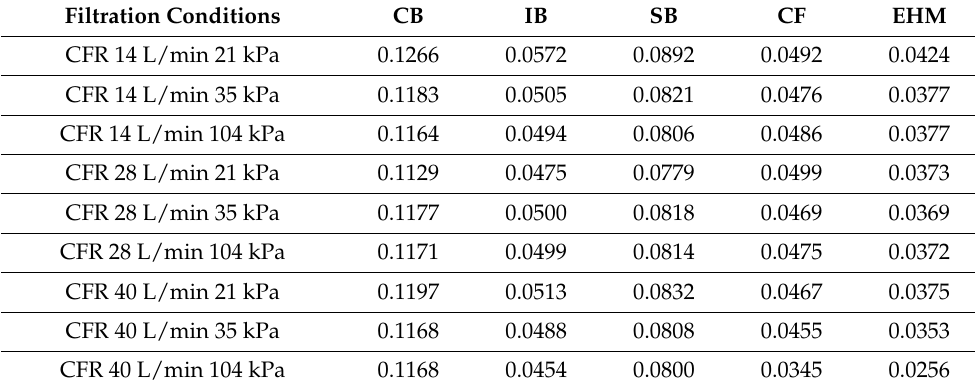
Table 9. RMSE results obtained in Example 3.